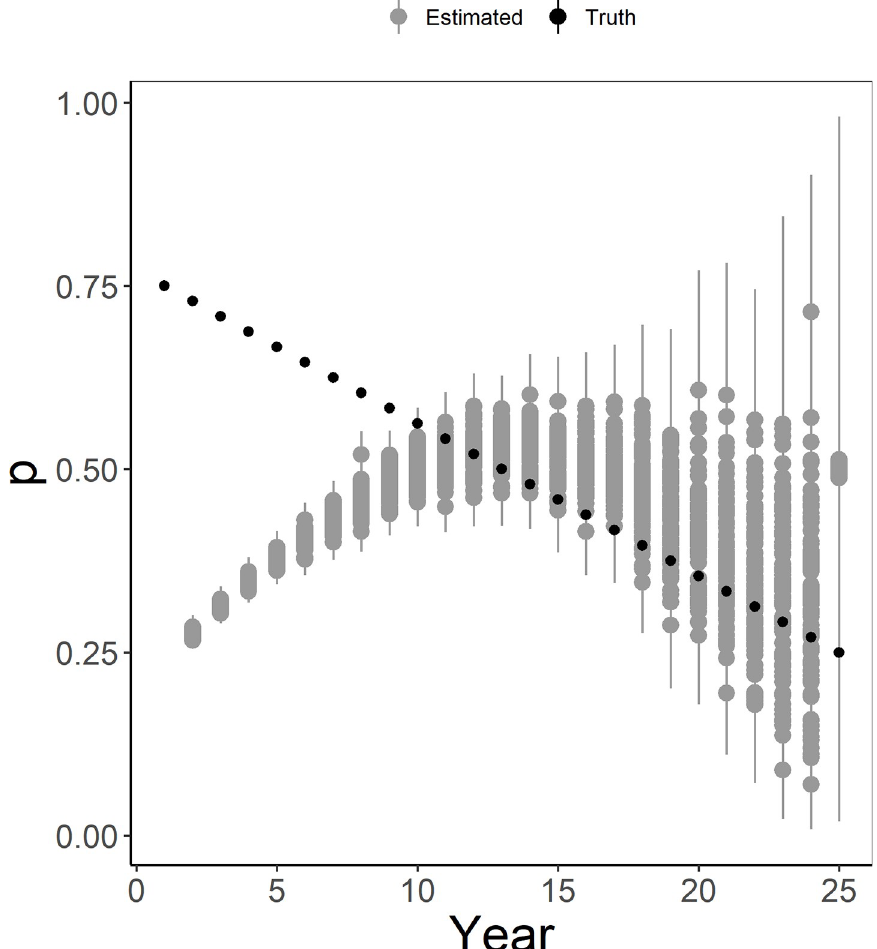
Fig 8. Detection probability estimates from models with decreasing detection probability. Detection probability estimates (“Estimated” in gray) of lesser prairie-chickens from an N-mixture model with detection probability decreasing by time (Scenario 11N). True values of detection probability are shown in black (“Truth”). Points represent mean or true values from each simulation and whiskers represent 95% quantiles for each simulation.